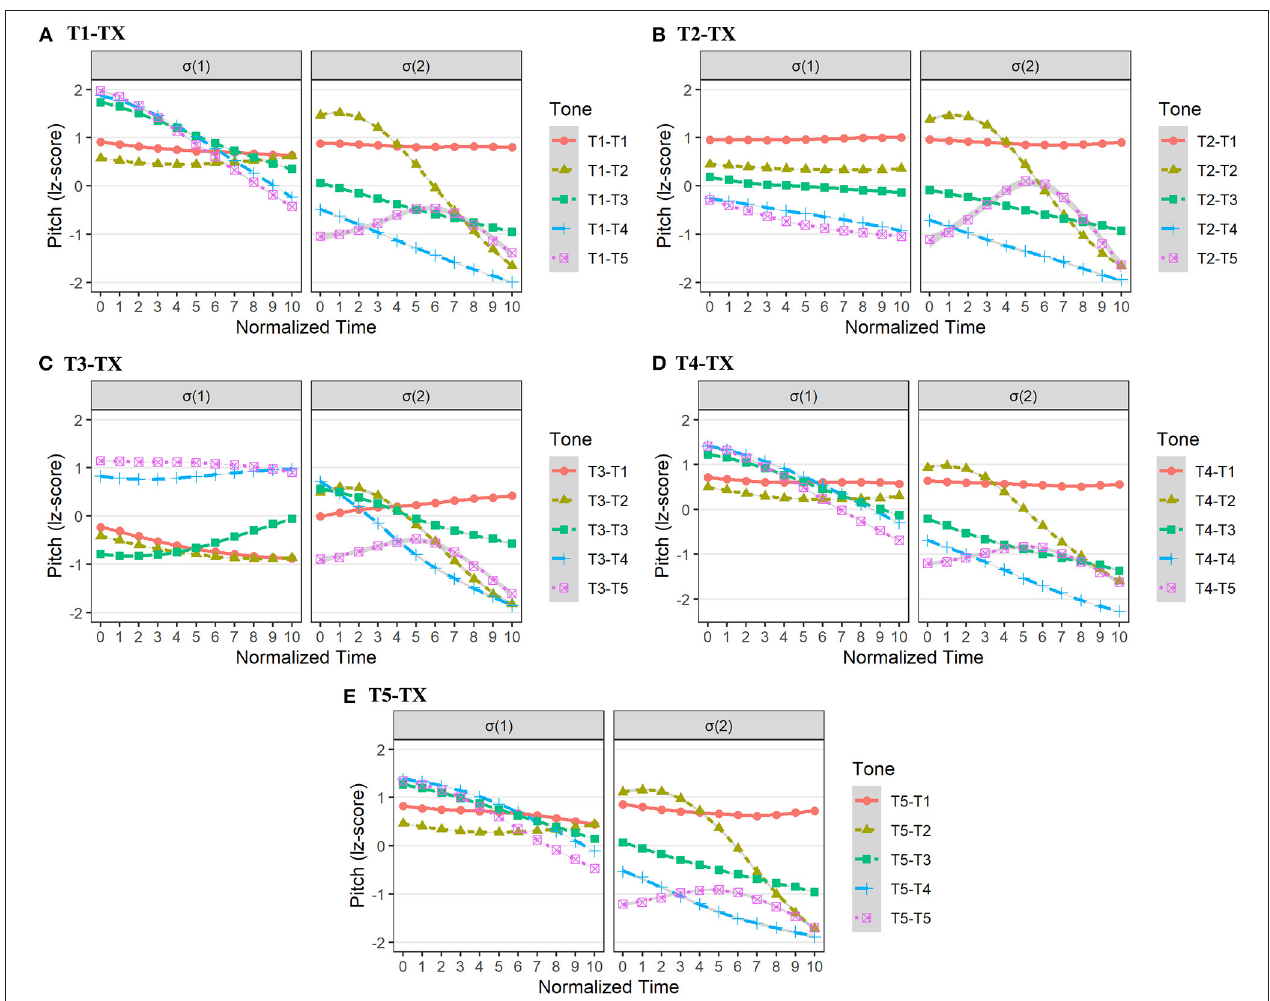
FIGURE 6 | The pitch realizations of σ (1) and σ (2) in Fuzhou dialect with tonal combinations of T1-TX (A) , T2-TX (B) , T3-TX (C) , T4-TX (D) , and T5-TX (E) .